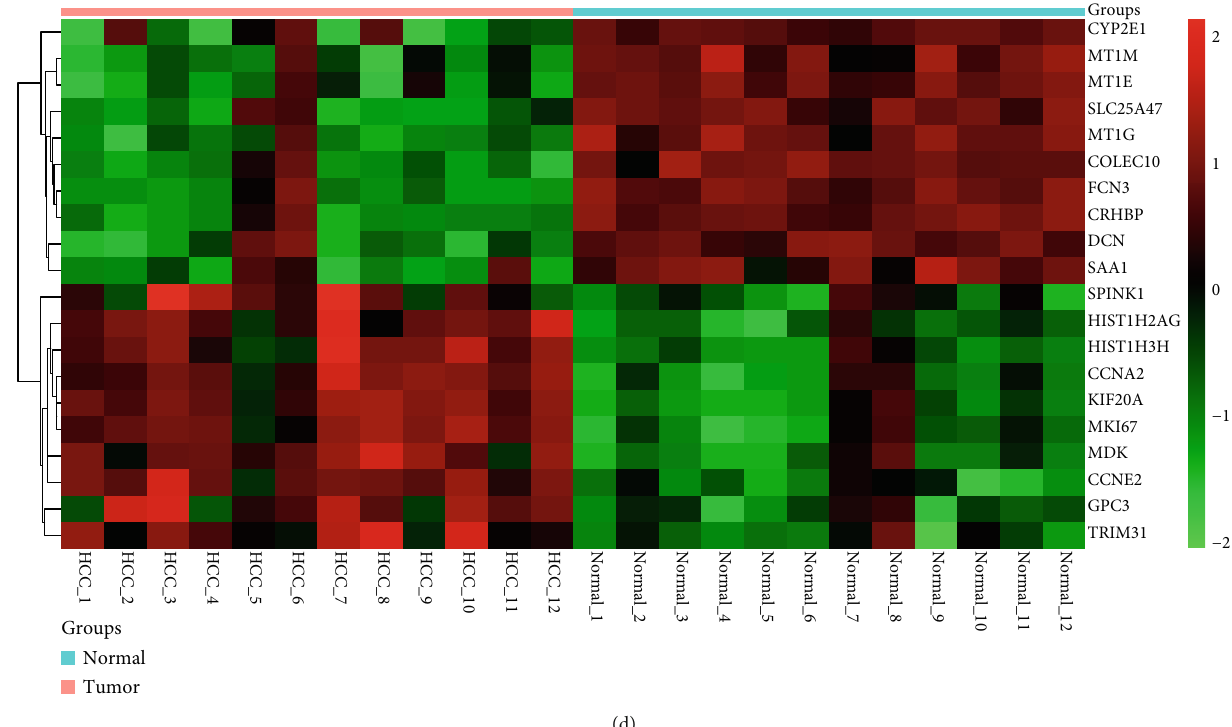
Figure 1: Identi fi cation of di ff erentially expressed mRNAs. Box plots show the distribution of the relative mRNA expression in each sample before (a) and after (b) normalization of GSE115018. Each box corresponds to one sample. The middle line corresponds to the median. (c) Volcano plot of di ff erentially expressed mRNAs. Di ff erentially expressed mRNAs were screened with criteria of adjusted P value < 0.05 and ∣ log2fold − change ð FC Þ ∣ ≥ 1 . (d) The cluster heat map of the top 10 upregulated and downregulated